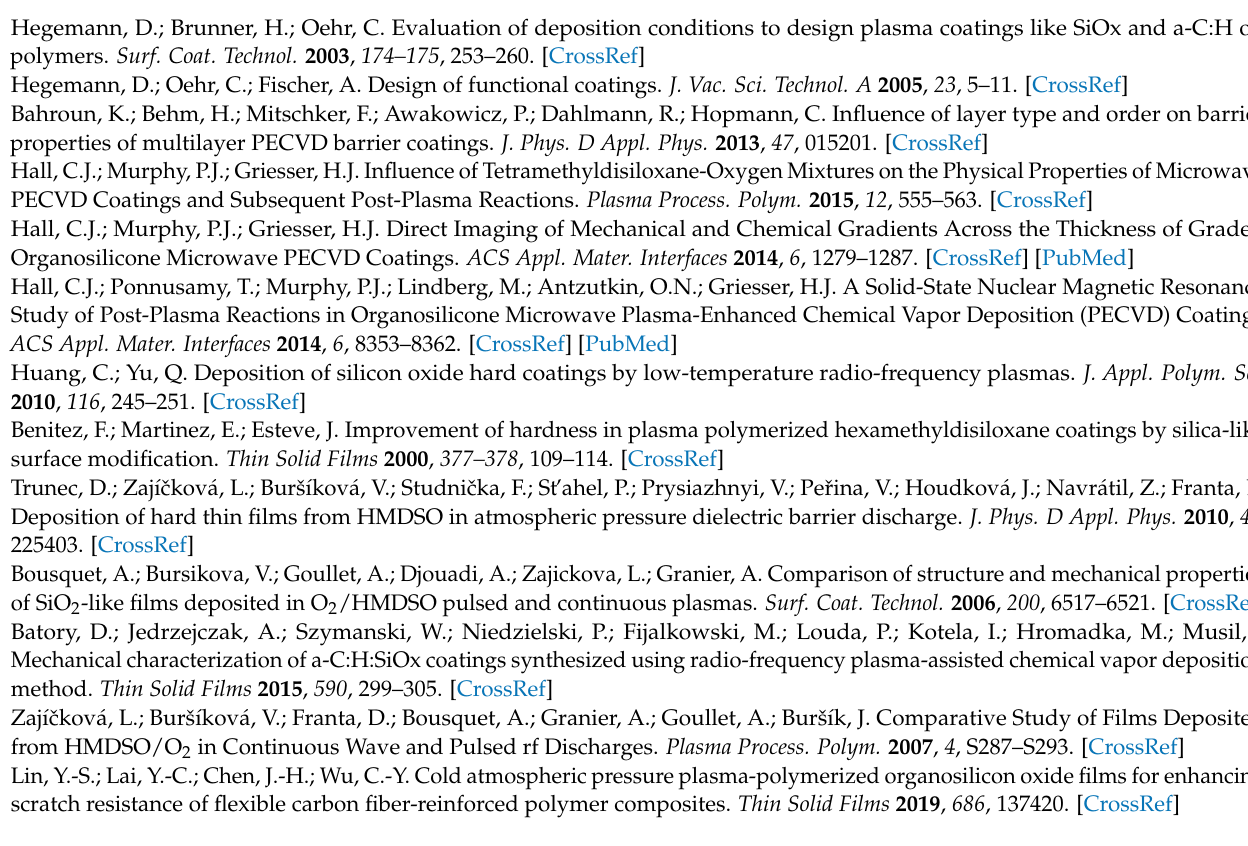
Figure S2: AFM surface topography scans and DMT-modulus maps of MW TMDSO films deposited at varying powers and O 2 concentrations, Figure S3: Nanoindentation surface topography scans of MW TMDSO films deposited at varying powers and O 2 concentrations after individual indents with increasing load. Scan sizes ranged from 0.5–2 µ m depending on load conditions and indenter shape, Figure S4: Young’s modulus of MW TMDSO films measured by nanoindentation for varying O 2 concentrations and deposition